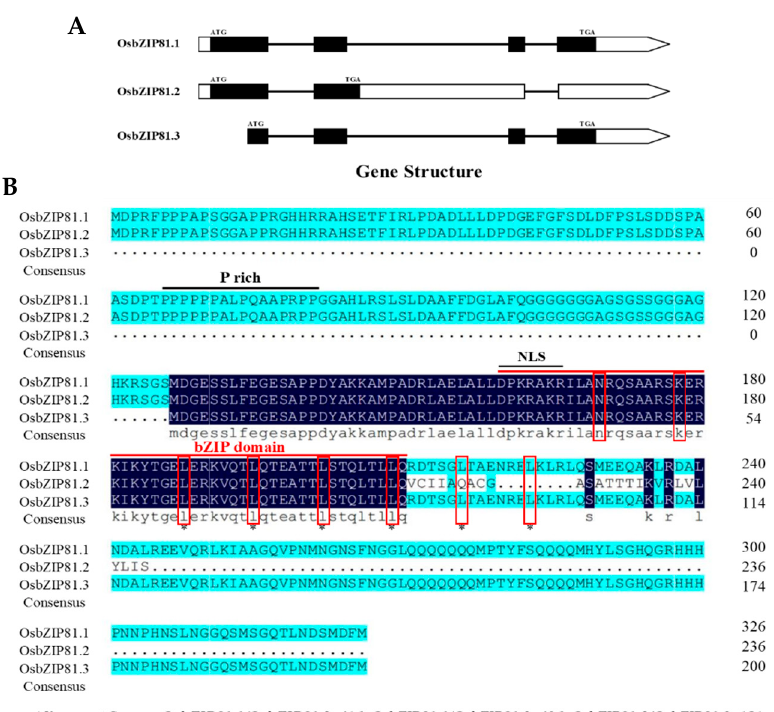
Figure 2. Gene structure and sequence alignment of OsbZIP81 variants. ( A ) Schematic representation of the OsbZIP81 genomic organization with UTRs (white boxes), exons (black boxes) and introns (lines between exons). ( B ) Alignment of the amino acid sequences of the OsbZIP81 variants. The conserved properties or sites were circled by red boxes.